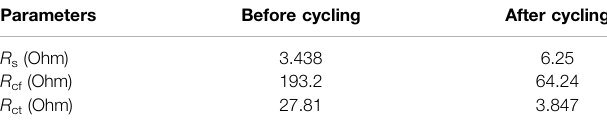
TABLE 2 | Kinetics parameters of NiS nanosphere